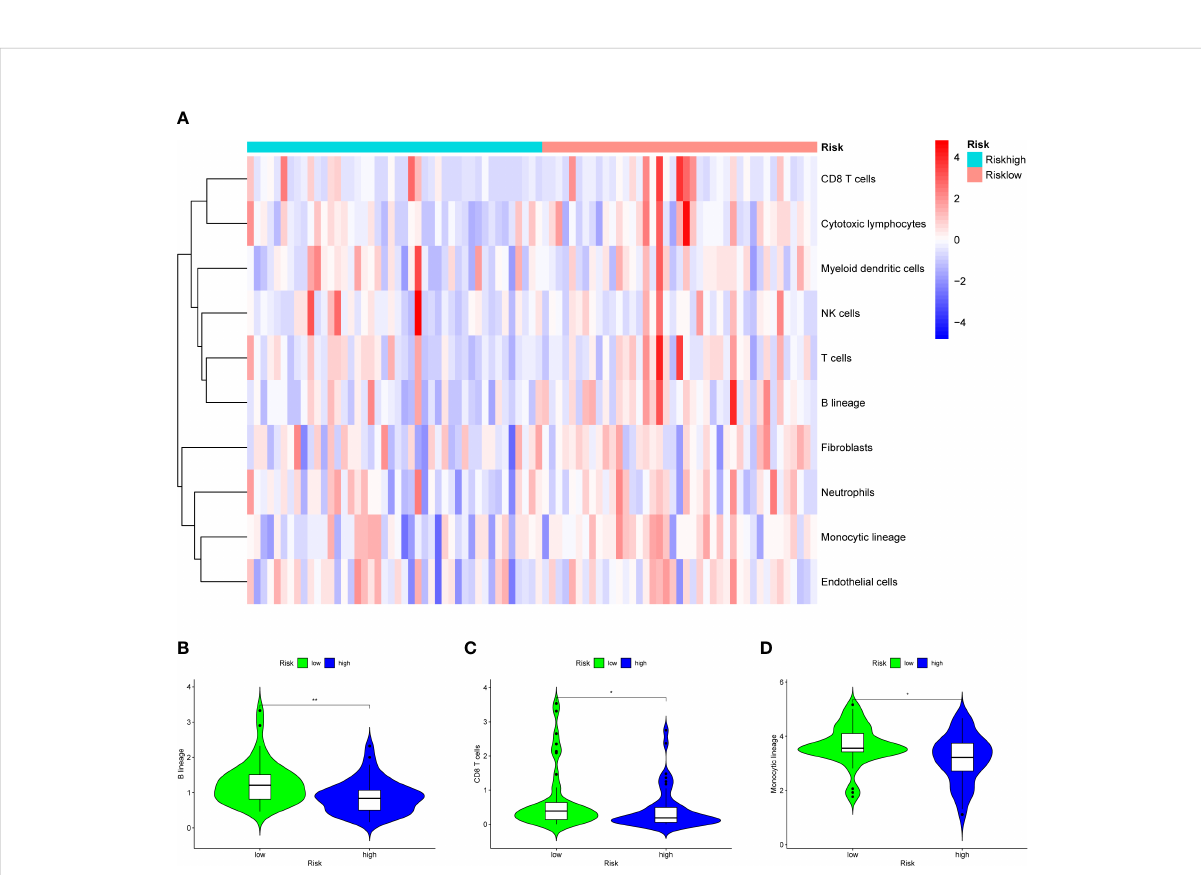
FIGURE 13 Results of MCPcounter analysis in the two groups to explore the immune in fi ltration. (A) A heatmap of 10 cell types in MCPcounter in the two groups. (B) A violin plot of B lineage in the two groups, which shows a signi fi cant lower level in high-OS group. (C) A violin plot of CD8 T cells in the two groups, which shows a signi fi cant lower level in high-OS group. (D) A violin plot of Monocytic lineage in the two groups, which shows a signi fi cant lower level in high-OS group. Due to above results, we could infer that SM-relevant genes may in fl uence the immune cells to change the immune environment in OS invalids. “ * ” represented “ p<0.05 ” , “ ** ” represented “ p<0.01 ”